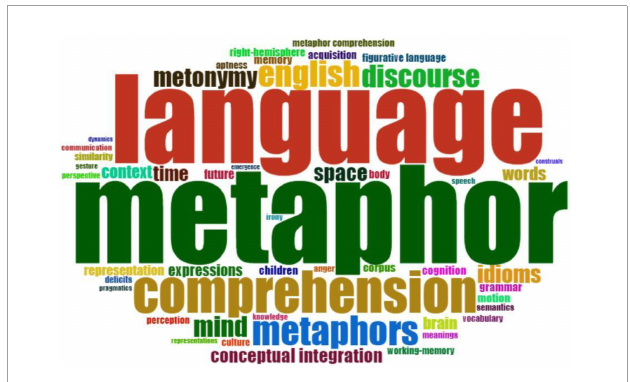
FIGURE10 Word cloud. Different words were colored differently, and the size and placement of the phrase denoted their frequency. The size of the colored words depicts the frequency of their